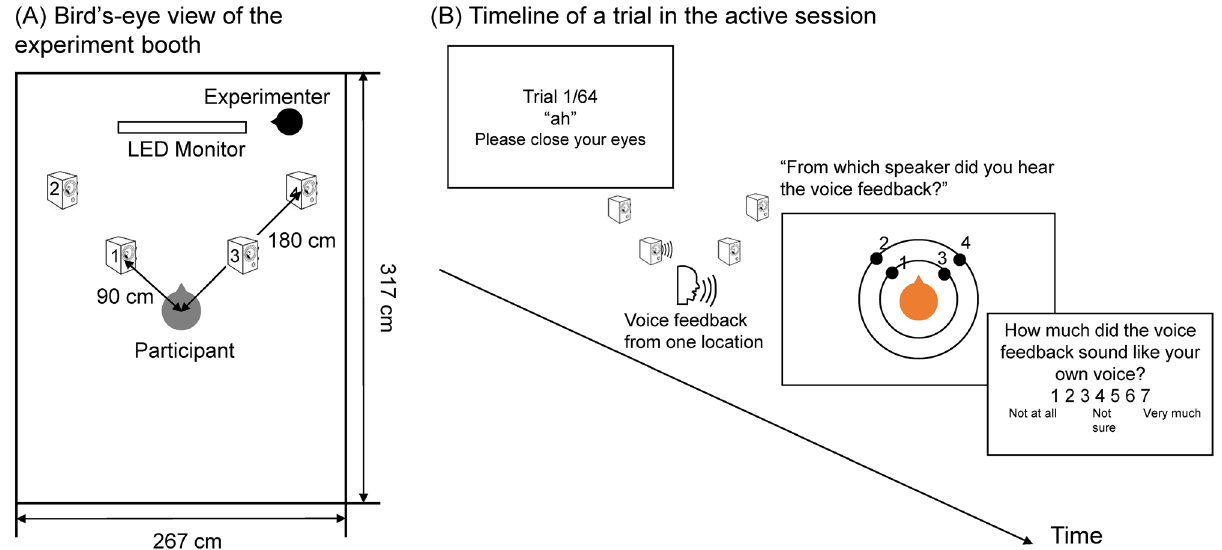
Figure 1. Setup of the experiment devices ( A ), and the timeline of a trial in the active session ( B